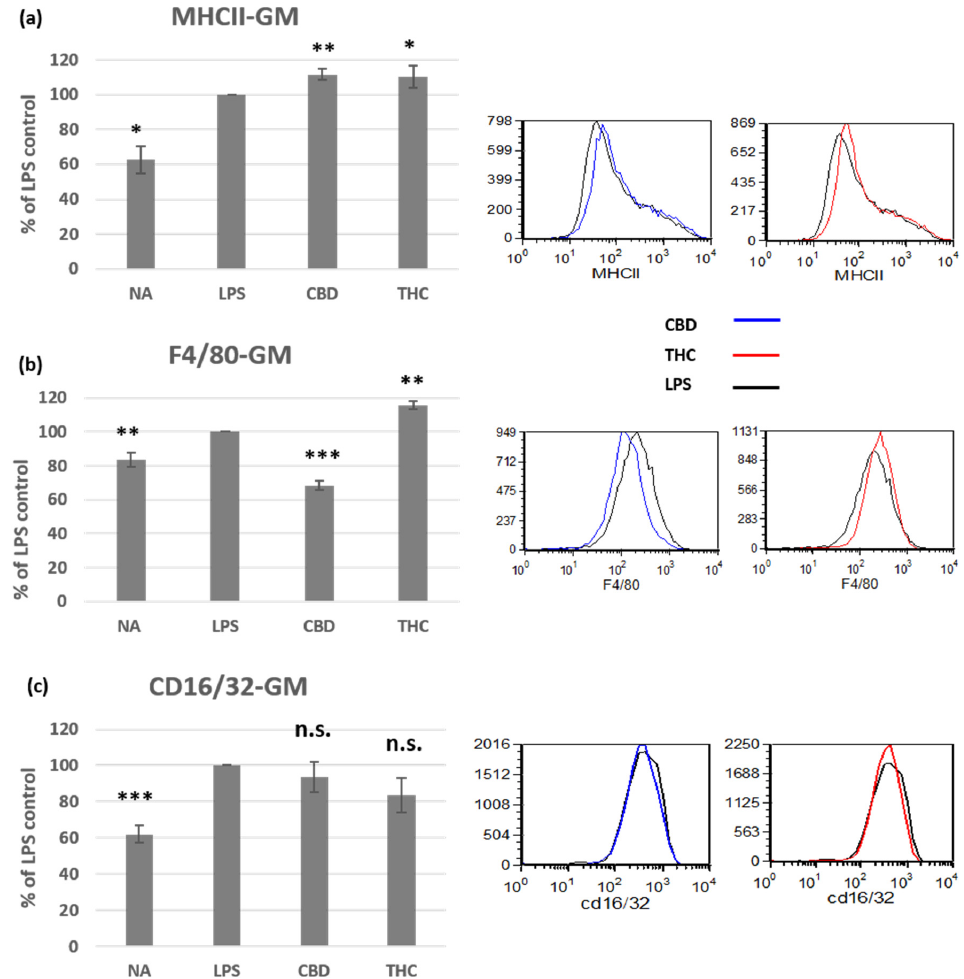
Figure 3 Figure 3. The effect of CBD and THC on the phenotype of LPS-activated peritoneal macrophages. Peritoneal macrophages from C57BL/6 female mice were activated for 24 h with LPS, in the presence of cannabinoid treatments (5 µ g/mL). Cell surface expression levels of MHCII (( a ), n = 5), F4/80 (( b ), n = 6), and CD16/32 (( c ), n = 7) were determined by flow cytometry. The results are expressed as mean + SEM. p -value as compare with LPS-activated control cells *, <0.05; **, <0.01; ***, <0.001. NA— non-activated; LPS—lipopolysaccharide-activated macrophages; THC—D9 tetrahydrocannabinol; CBD—cannabidiol; n.s.—not